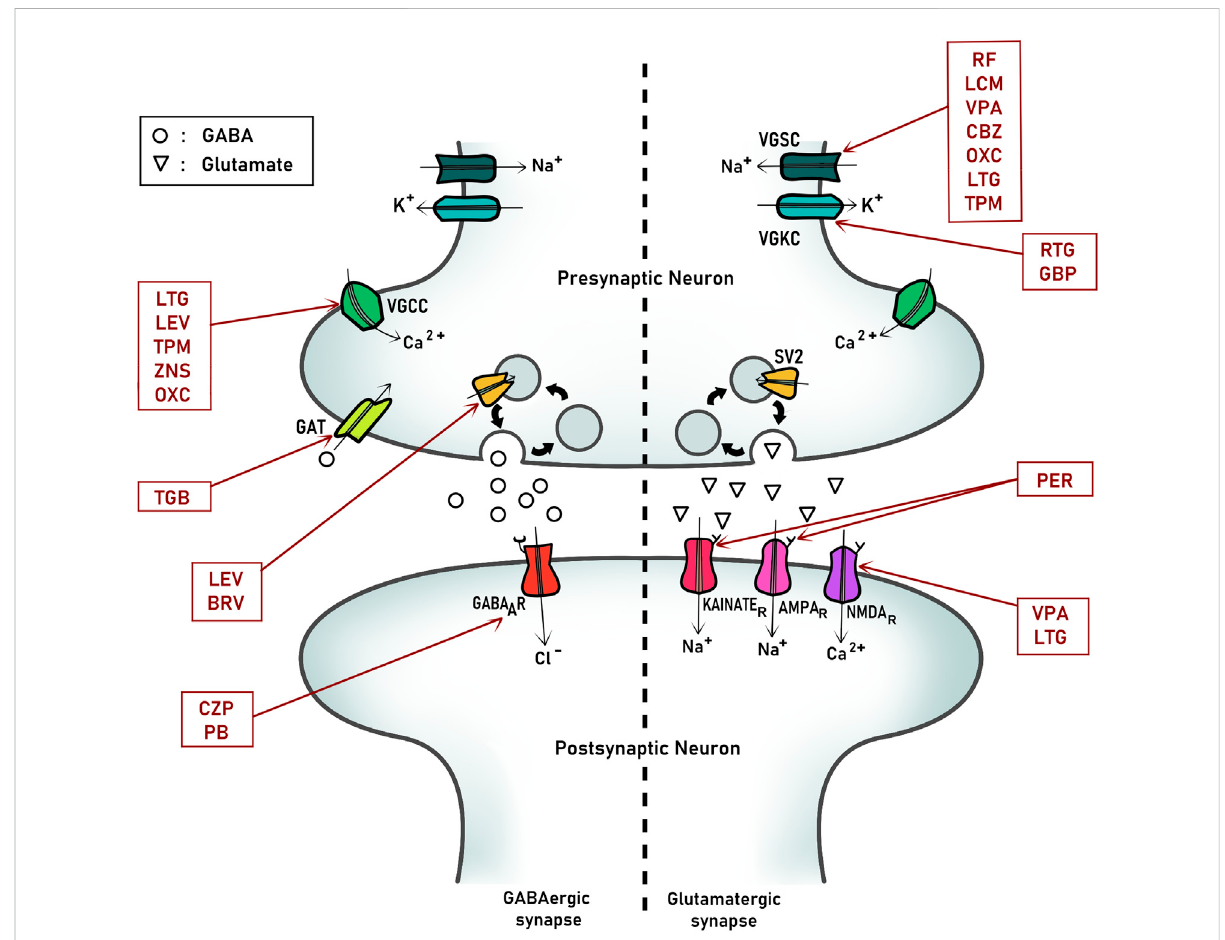
FIGURE 1 Principal pharmacological targets of antiseizure medication (ASMs) at synapses. A representative scheme of an inhibitory (GABAergic, left) and excitatory (Glutamatergic, right) synapse from a mature nervous system. The main proteins and ion channels targets of relevant antiseizure medicationsareindicated.VCCC,Voltage-gatedcalciumchannel;VGSC,Voltage-gatedsodium channel;VGKC,Voltage-gatedpotassiumchannel; SV2, Synaptic-vesicle protein 2. LEV, Levetiracetam; TPM, Topiramate; TGB, Tiagabine; BRV, Brivaracetam; CZP, Clonazepam; PB, Phenobarbital; RF, Ru fi namide; LCM, Lacosamide; RTG, Retigabine; GBP, Gabapentin; PER, Perampanel; VPA, Valproate; CBZ, carbazepine; LTG, Lamotrigine; OXC,